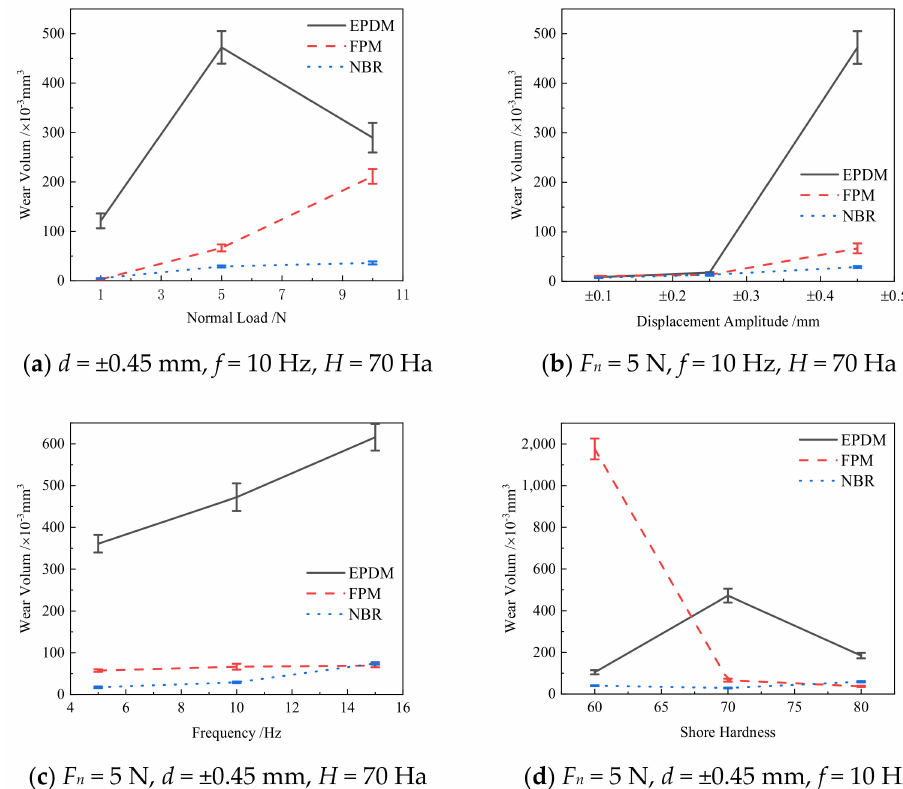
Figure 11. The wear volume of three